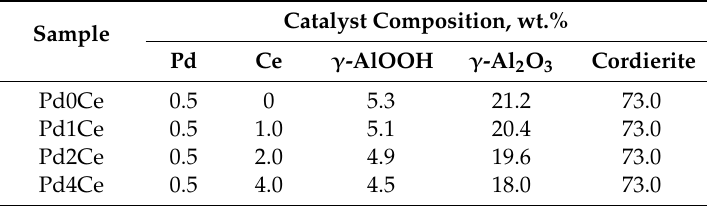
Table 5. Nominal composition of monolith